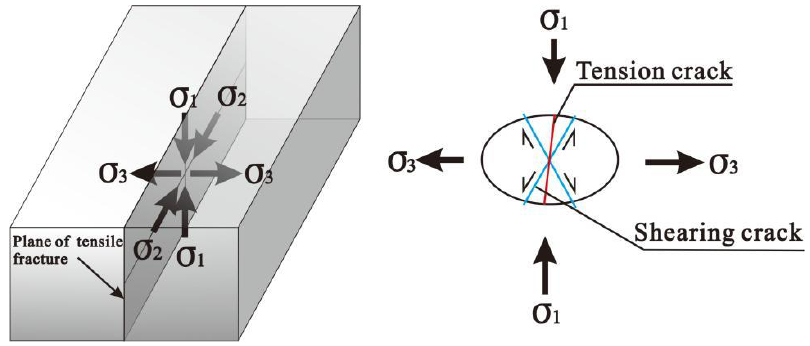
Figure 3. Schematic diagram of the mechanics of tension crack formation [16].